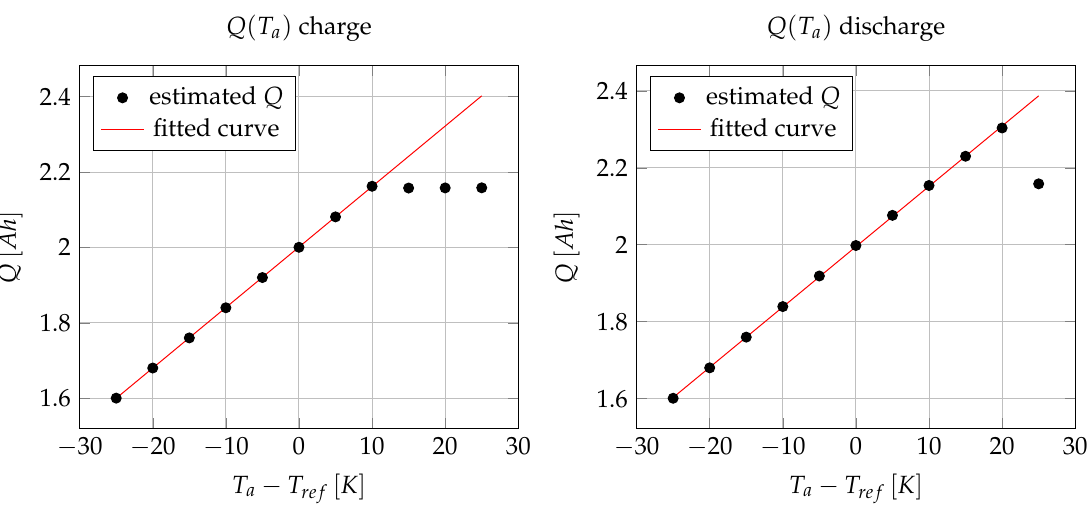
Figure 5. Estimation of the temperature dependency of E 0 .